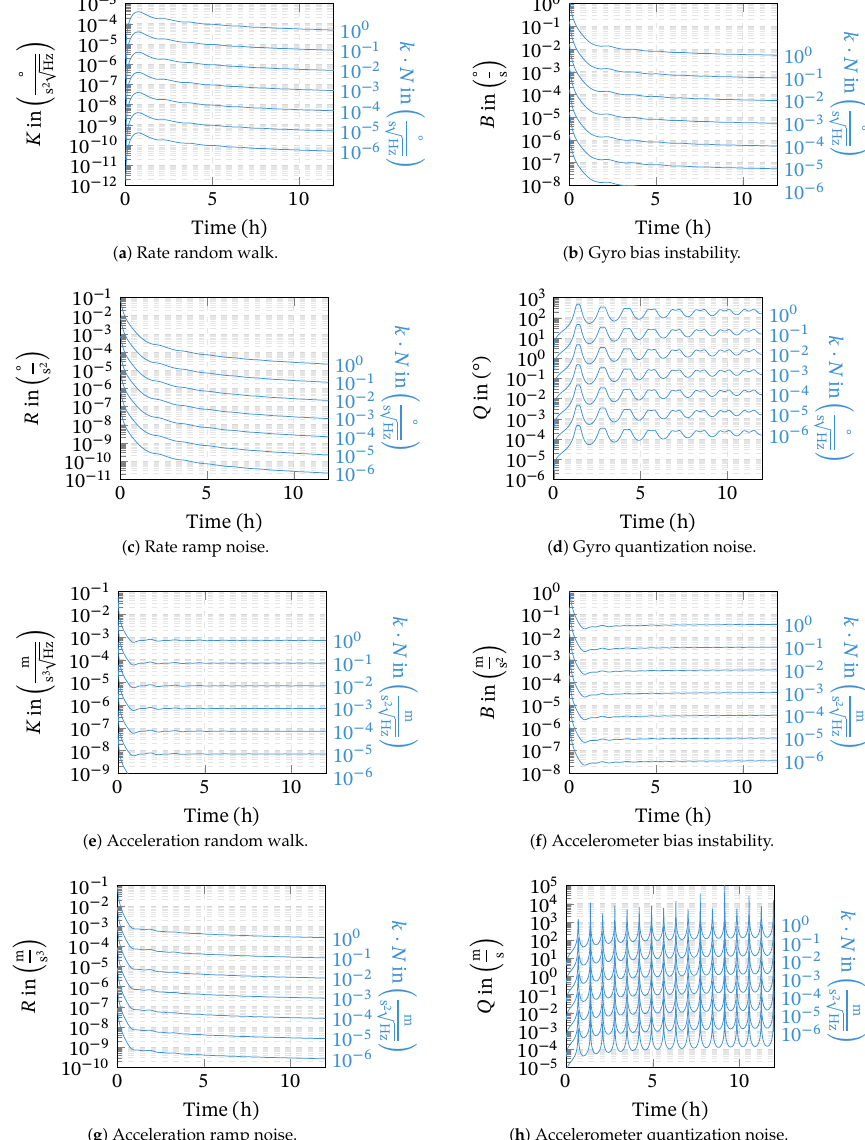
Figure 12. Maximum noise coefficients for scaled angular/velocity random walk coefficient kN over time. Graphs were determined for a latitude of 45 ◦ and an altitude of 0m. For a given time t , the lines indicate the noise coefficients where e.g., the bias instability’s contribution to the position uncertainty is a fraction k of the angular random walk’s